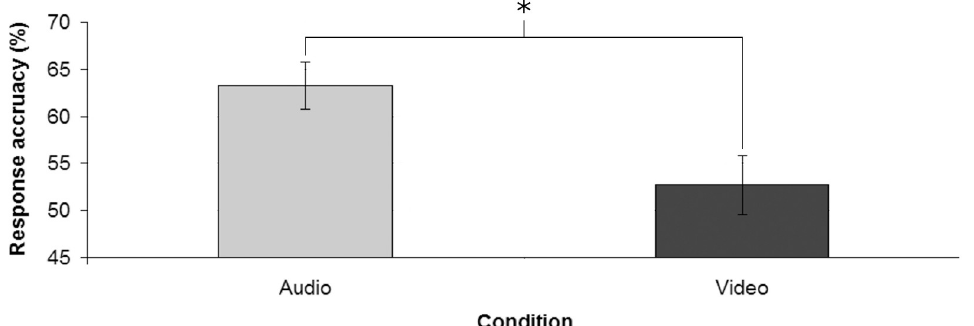
Fig 6. Response accuracy in the two conditions. Error bars show the standard error of the mean; � denotes statistical significance.